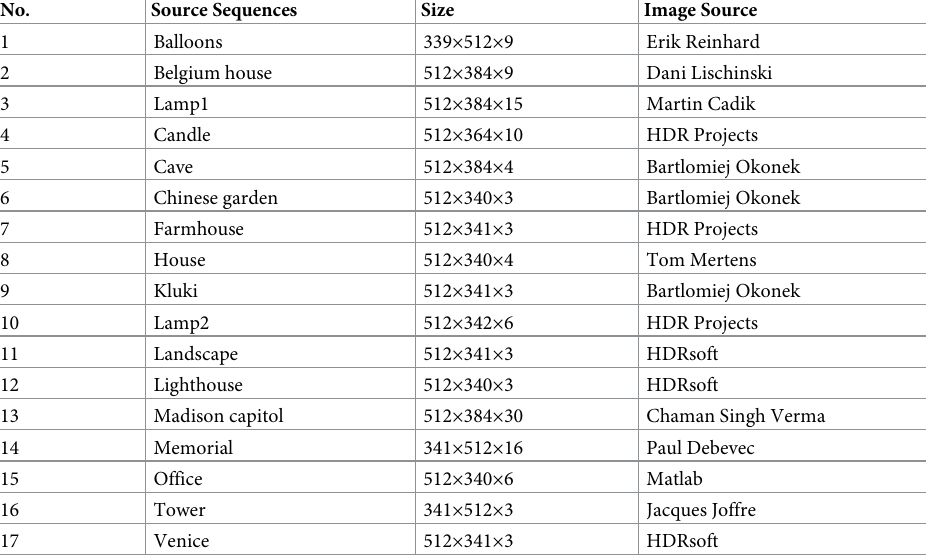
Table 1. The details of the MEF image database [40]. No. Source Sequences Size Image